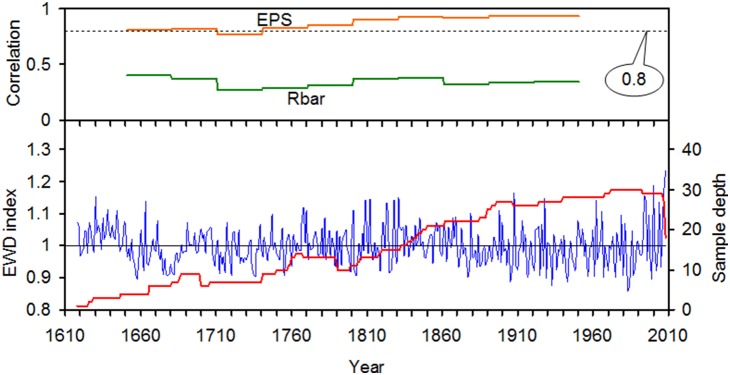
Plot of the standard EWD chronology of the Shimen Mountains, its running expressed population signal (EPS), sample depth and mean inter-series correlation (Rbar).